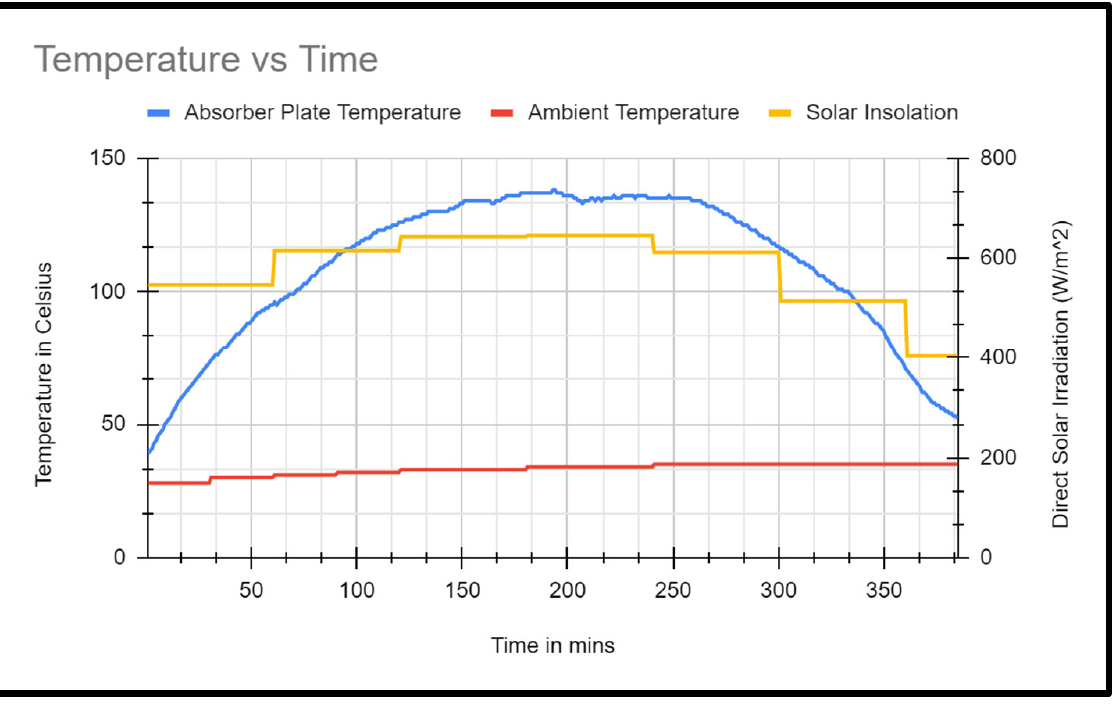
Figure 10. Temperature and irradiation values from day 4 with no test load for first figure of merit.